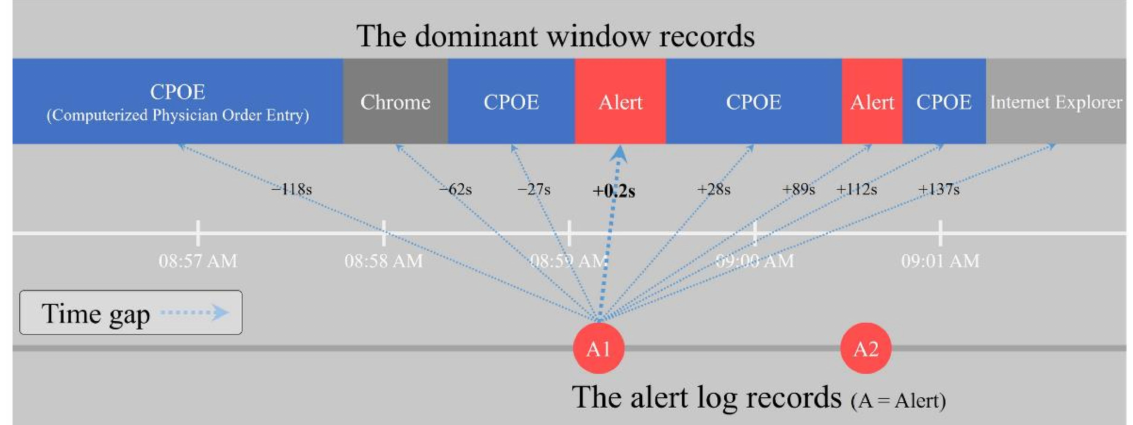
Figure 3. A schematic diagram of the time gap calculation. Rectangles with different colors, red circles, and blue dashed arrows represent dominant window records, alert log records, and time gaps, respectively. In this example, the time gaps were − 118 s, − 62 s, − 27 s, +0.2 s, etc. In this case, the minimal time gap between the ALC and DWD records of the relevant alert is 0.2